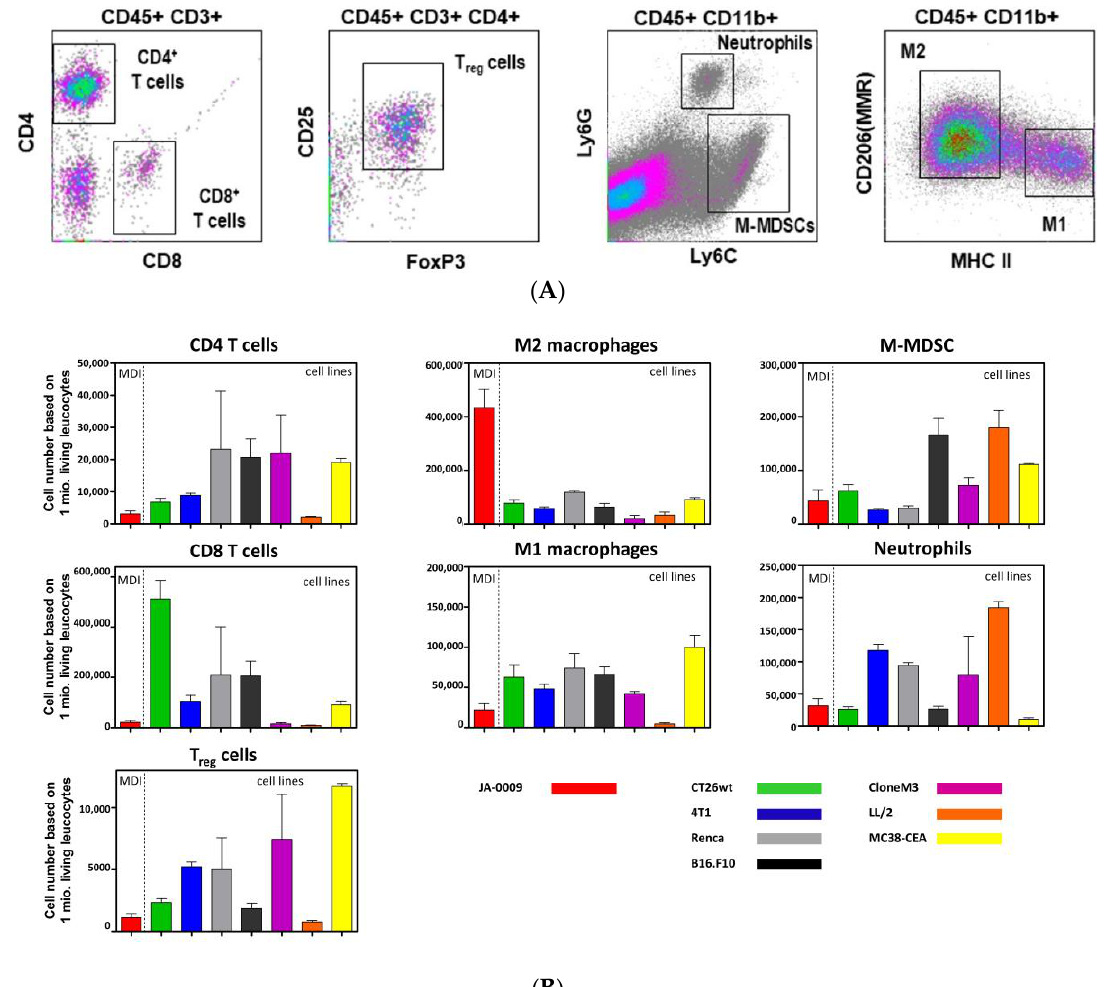
Figure 5. ( A ) Flow cytometric analysis of tumor infiltrating leukocytes (density dot plots) in sMDI JA-0009. Representative flow cytometry blots of tumor infiltrating CD4 + /CD8 + T-cells, Treg cells, M-MDSCs, neutrophils/G-MDSC (cells of CD11b + , Ly6G + , Ly6C int phenotype), and M1/M2 macrophage subpopulations isolated from untreated syngeneic adenocarcinoma mouse model JA-0009 sMDI. M-MDSC = monocytic myeloid-derived suppressor cells, MMR = macrophage mannose receptor, Treg = regulatory T cells. ( B ) Quantitative flow cytometric analysis of tumor infiltrating leukocytes in sMDI